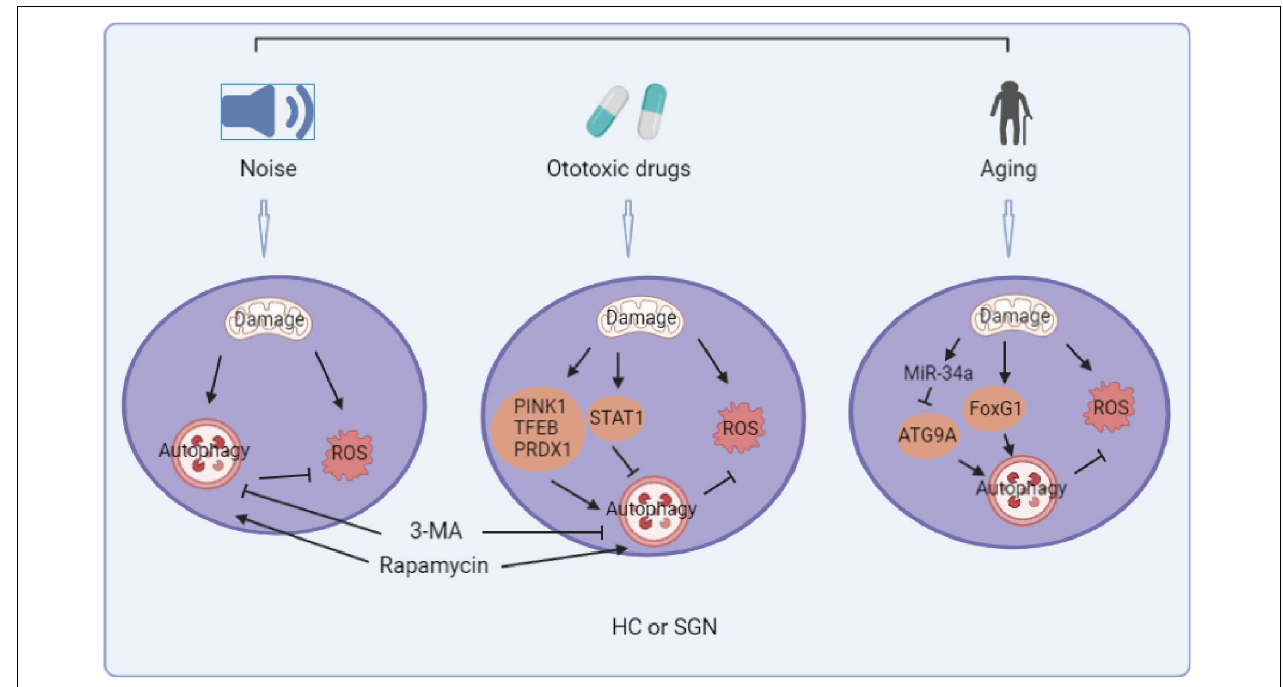
FIGURE 1 | Summary diagram of the role of autophagy in noise, ototoxic drug, and age-induced sensorineural hearing loss. (The picture is created in